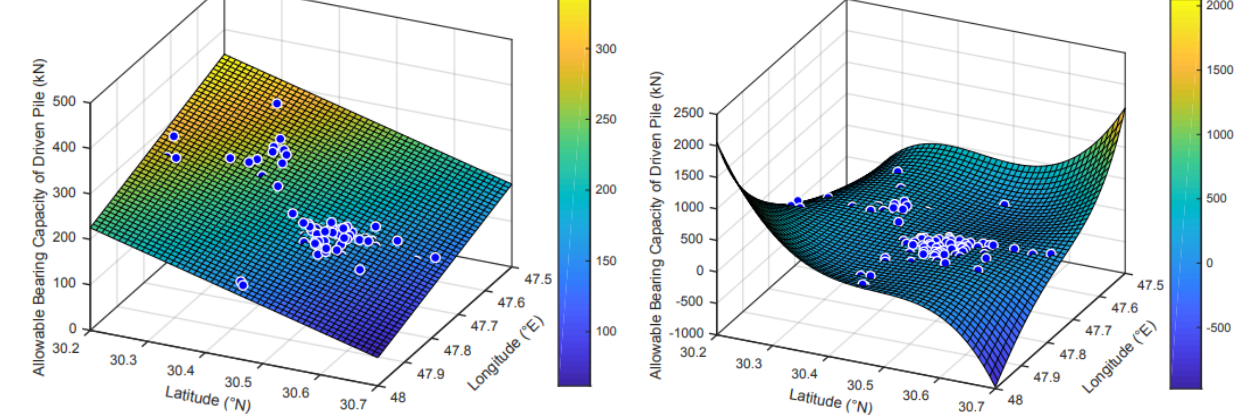
Figure 6: Variation the allowable bearing capacity of driven pile (6 m length) using 4 th order